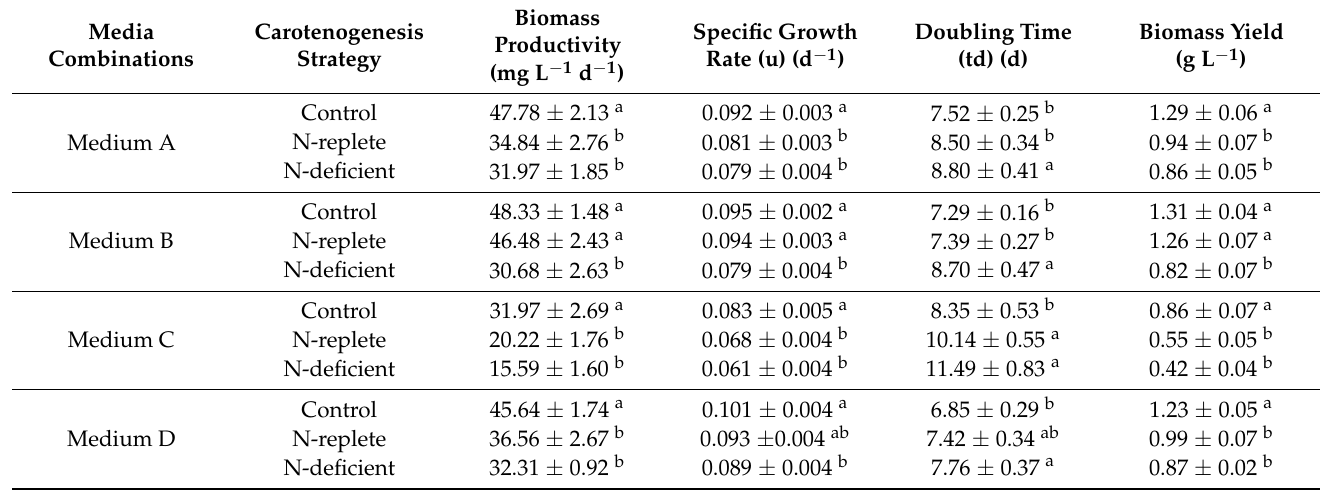
Table 2. Kinetics of Coelastrella sp. growth cultivated with the four BG-11 modified media (A:N+P-, B:N-P+, C:N-P-, D:N+P+) and further sub-categorized by the three subsequent